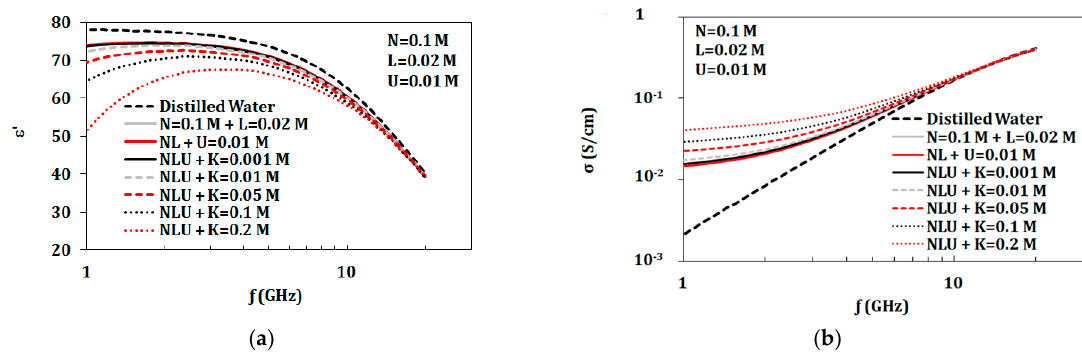
Figure 9. Measured dielectric properties for KCl solutions at ion concentrations from 0.01 to 0.2 mol/L with a base of 0.1 mol/L NaCl, 0.016 mol/L urea, and 0.02 mol/L lactic acid at temperature 23 °C in the range of 1–20 GHz: ( a ) dielectric constant and ( b ) conductivity (“M” refers to mol/L).